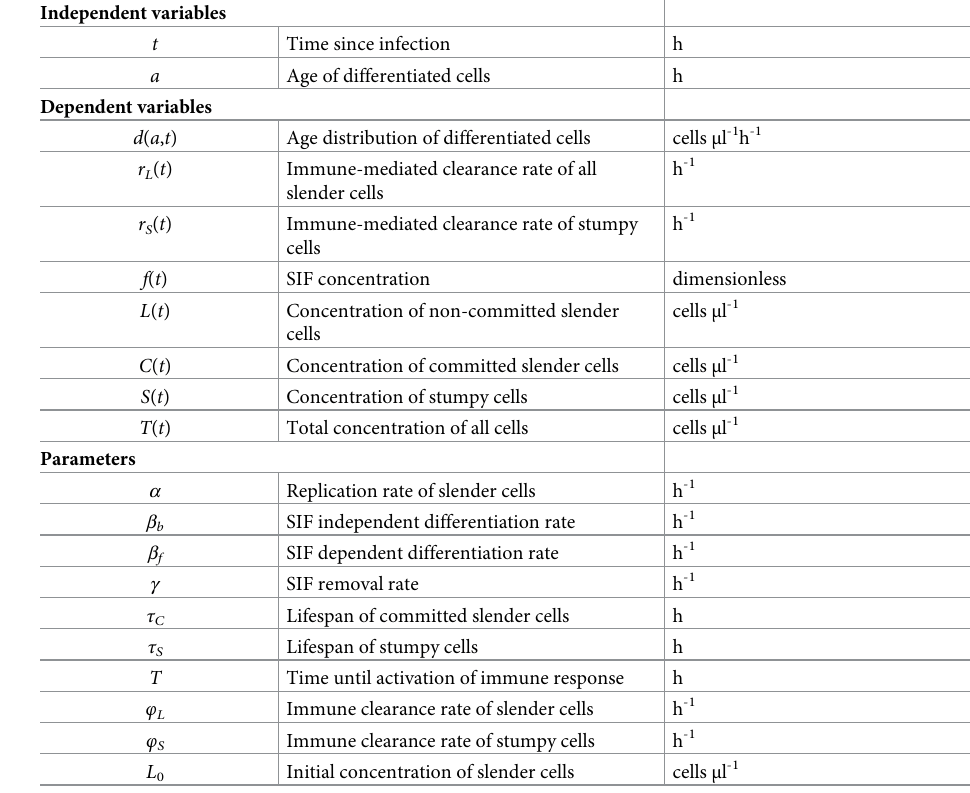
Table 3. Variables and parameters used in the mathematical